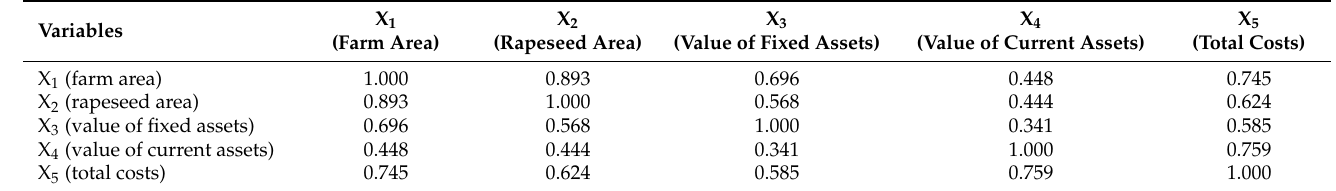
Table 9. Correlation